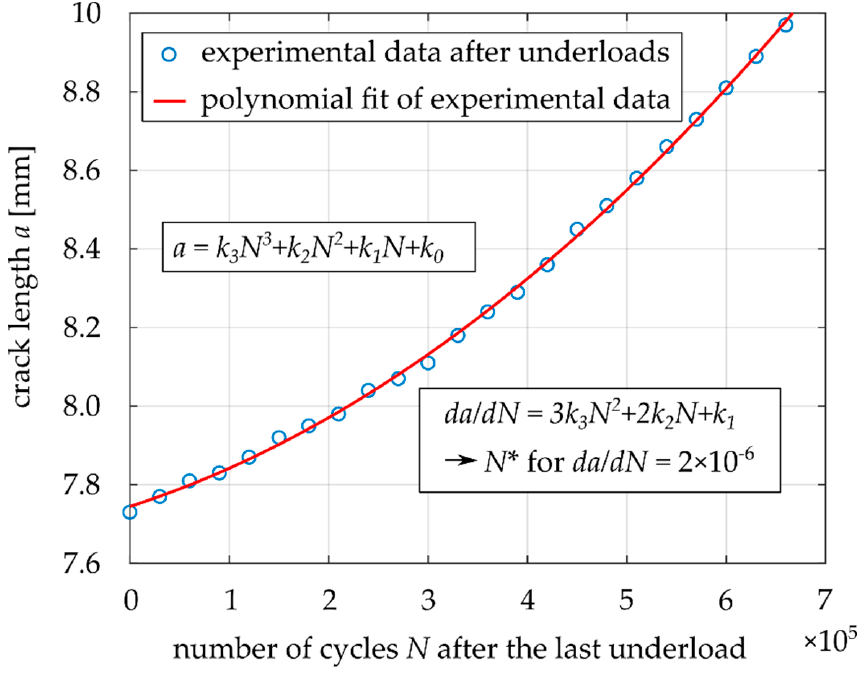
Figure 10. Determination of the number of influenced base load cycles after application of the underload cycles based on the fitting equation.